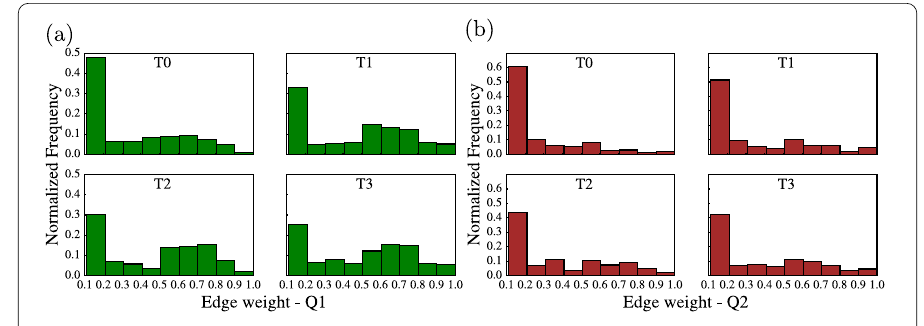
Figure 3 Histograms of weights for the networks defined by the two questionnaires. ( a ) Q1. ( b ) Q2